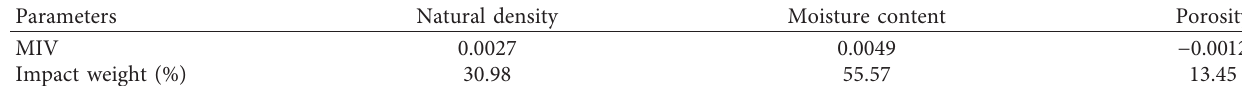
Table 3: MIV and impact weight of the input